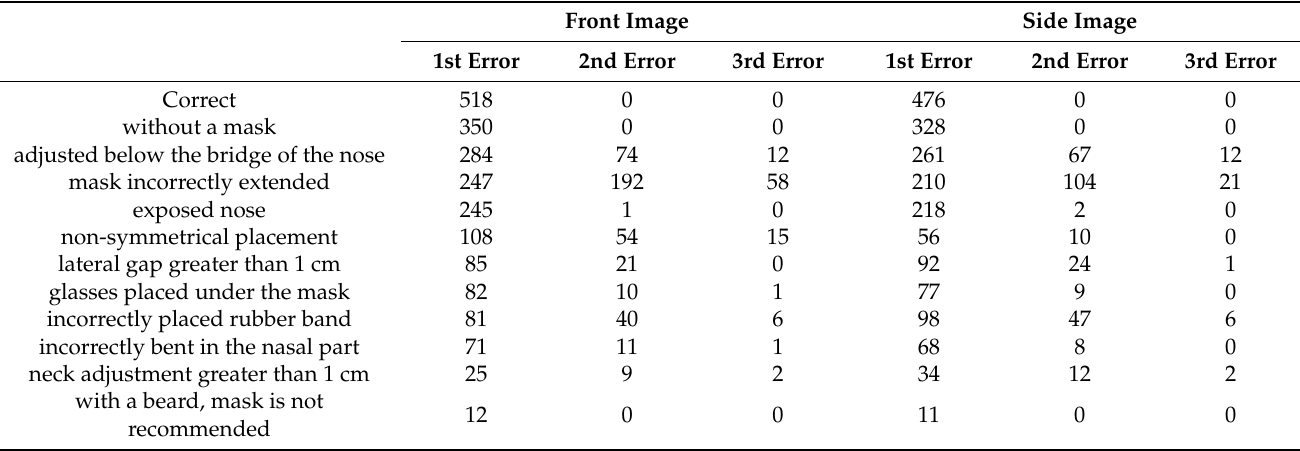
Table 2. Statistics of the labeling